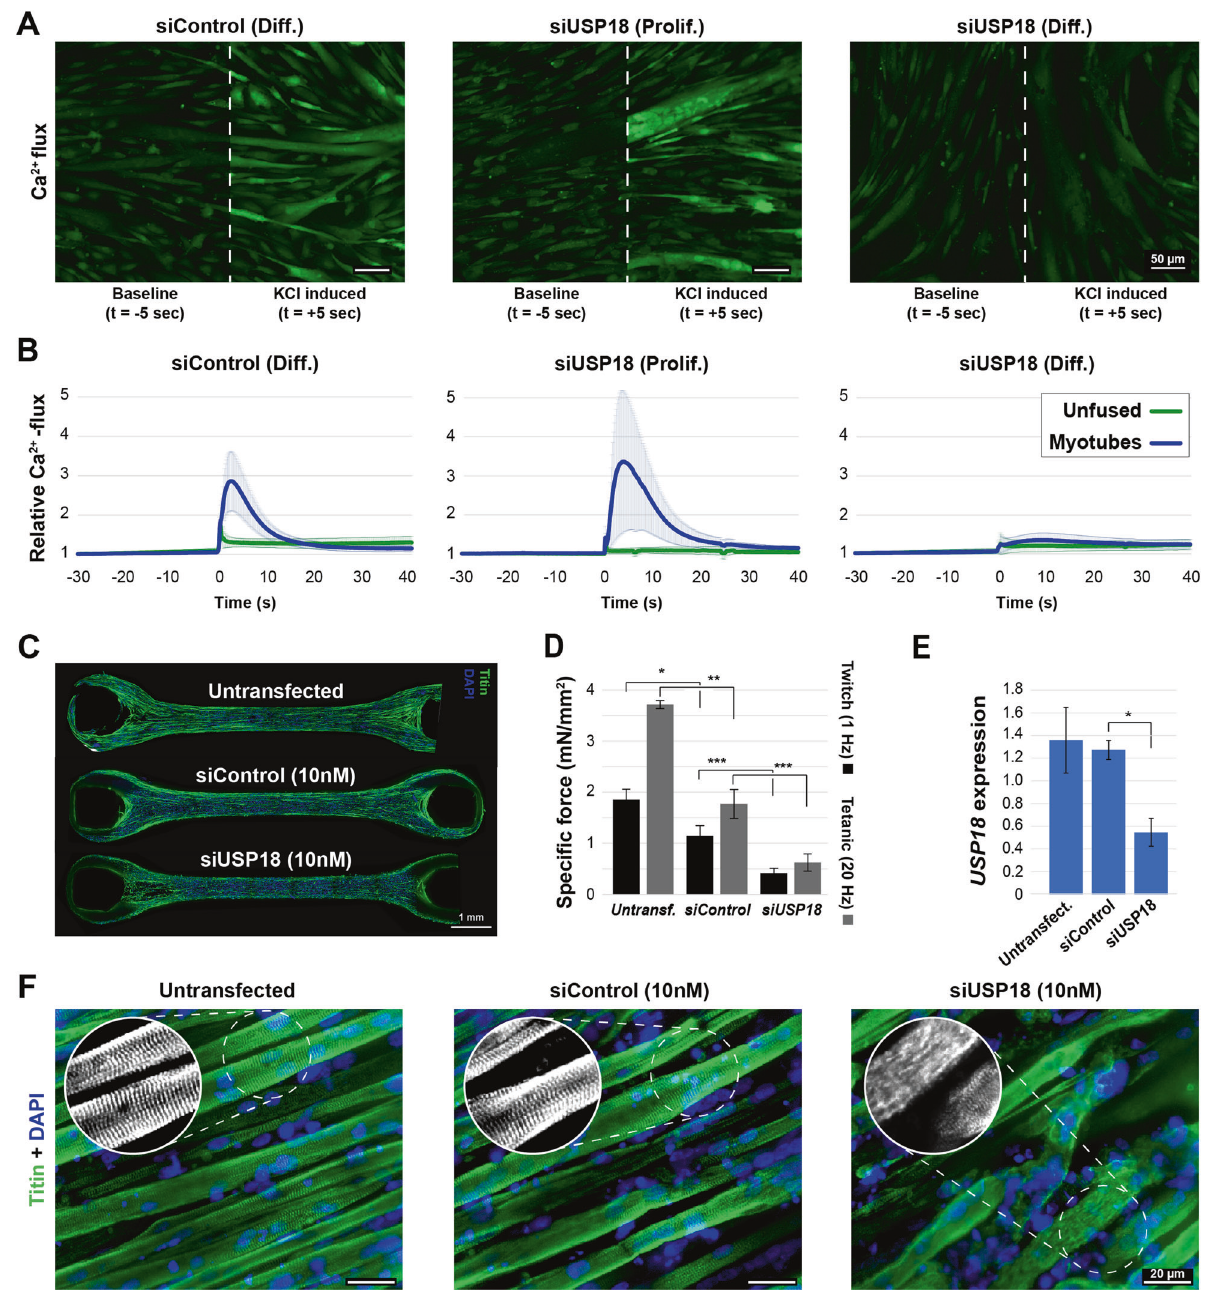
Fig. 8 USP18 KD negatively affects muscle physiology in vitro. A Representative images of the calcium fl ux (green signal) 5 s before or after KCl (10 mM) administration in immortalized muscle cells transfected with siControl in differentiation medium (Diff.) or with siUSP18 in proliferation or differentiation medium. The respective images are separated by a white dashed line. Scale bar is 50 μ m. B Graphs show changes in calcium fl ux over time. Calcium fl ux in uni-nucleated cells (unfused) is depicted by a green line and multinucleated cells (myotubes) by a blue line. Average and error bars (SD) are from N = 3 biological replicates. C An image of a representative bundle made with muscle progenitor cell line stained for titin (green) and nuclei (blue) for each genetic condition. Scale bar is 1 mm. D Bar chart shows the speci fi c contractile forces (in mN/mm 2 ) at 7 days of differentiation for USP18 KD and controls. Twitch (1 Hz) and tetanic (20 Hz) contractions are depicted by black or gray bars, respectively. Average and SD are from contractions of four different muscle bundles. E Bar chart shows USP18 expression levels normalized to untreated muscle bundles at 7 days of differentiation. Averages and SD are from N = 3. Statistical signi fi cance in panel D and E is depicted by asterisks. (*0.05 – 0.005, **0.005 – 0.0005, ***< 0.0005). F High resolution images show titin architecture in muscle bundles after 7 days of differentiation. The colored images show titin in green and nuclei in blue. Gray scale images show titin staining only. Scale bar is 20 μ m. irrespective of serum starvation. USP18 also plays a role in regulates muscle cell differentiation independent of ISG15 and differentiation and maturation, ensuring proper expression of probably (de)ISGylation as there are no detectable changes in sarcomeric genes. Future research will have to pinpoint the exact protein ISGylation during differentiation. USP18 depletion causes molecular mechanism by which USP18 is induced and how muscle cells to switch from proliferation to differentiation Cell Death and Disease (2023)